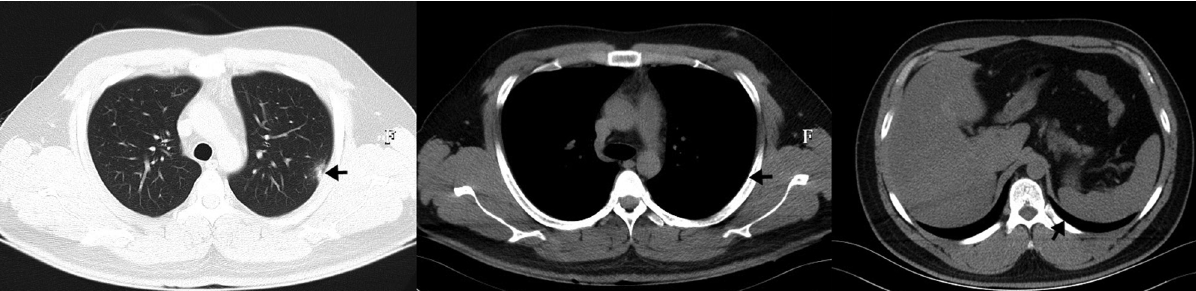
Figure 2: Chest CT after 6 weeks of treatment, showing the cavity disappeared, leaving only a little patchy in fi ltration. The pleural thickening was